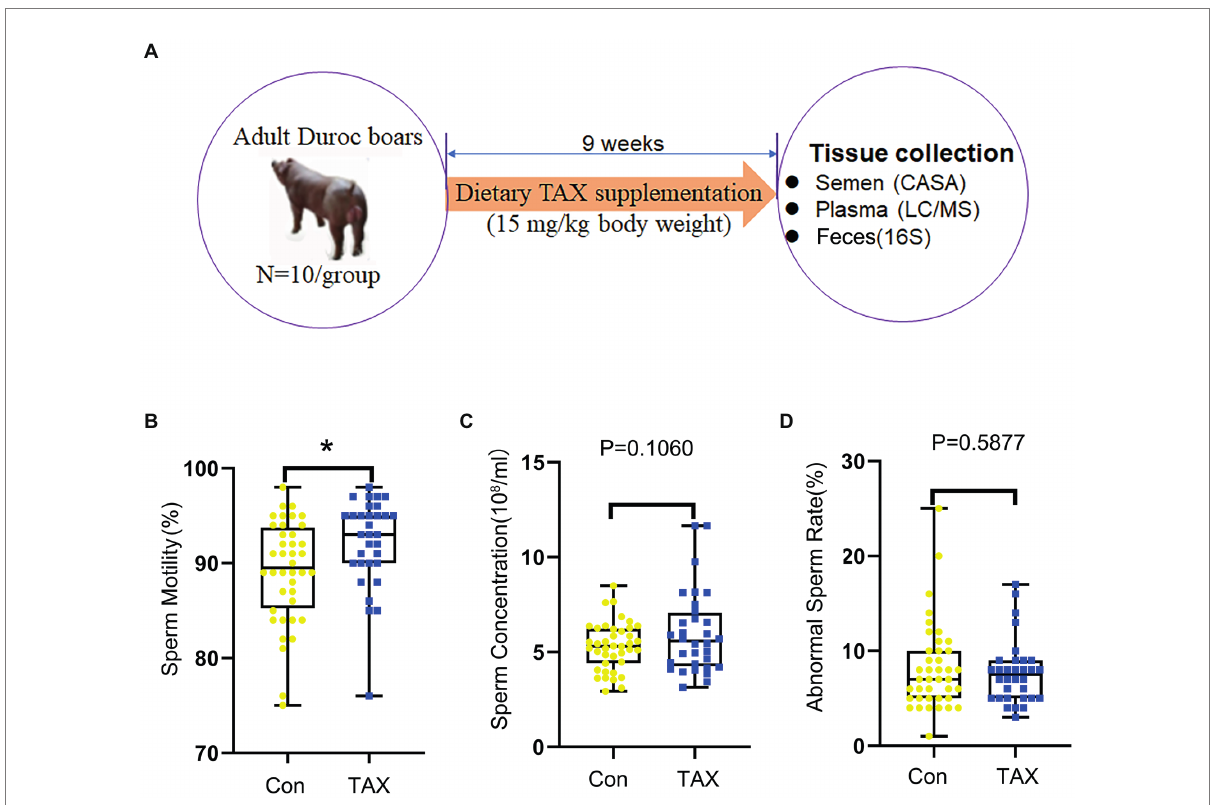
FIGURE 1 Effects of TAX on semen quality. (A) Study design. (B) Sperm motility. The y-axis represents the percentage of total cells. The x-axis represents the treatment ( n = 10/group). * p < 0.05. (C) Sperm concentration. The y-axis represents the concentration. The x-axis represents the treatment ( n = 10/ group). (D) Abnormal sperm rate. The y-axis represents the percentage of total cells. The x-axis represents the treatment. Data were expressed as the mean ±